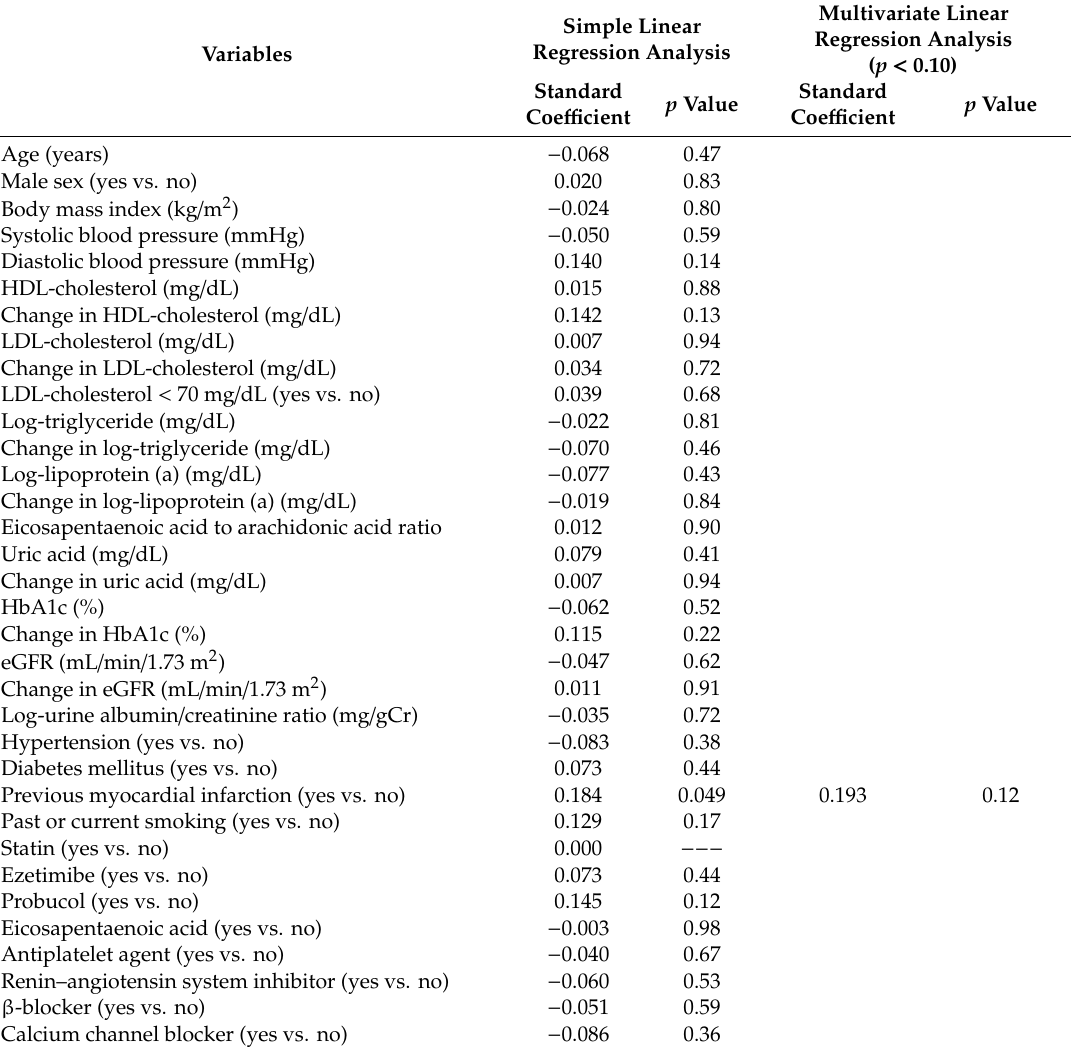
Table 3. Simple and multiple linear regression analyses of variables associated with the change in stability (evaluated by minimum CT density) of vulnerable coronary plaques during the administration of evolocumab. Simple Linear Regression Variables